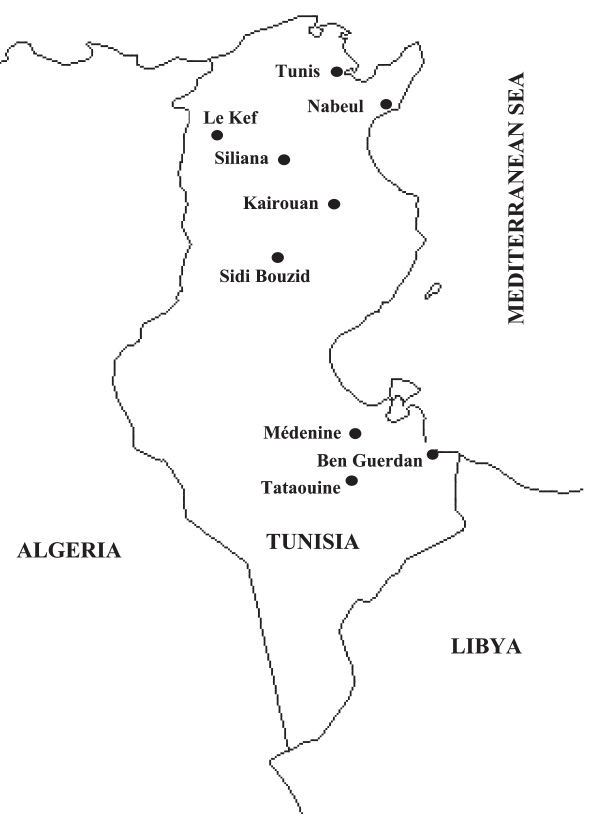
Table I. – Prevalence of Cryptosporidium in farm animals.